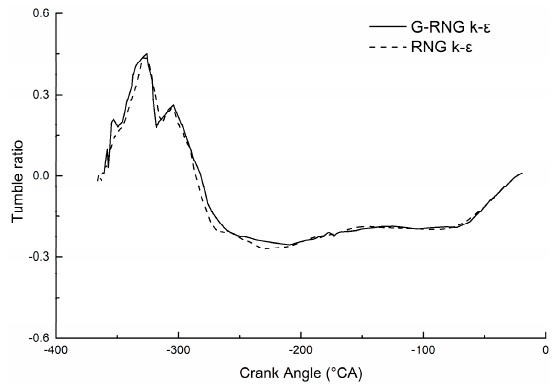
Figure 5. In-cylinder tumble ratio.